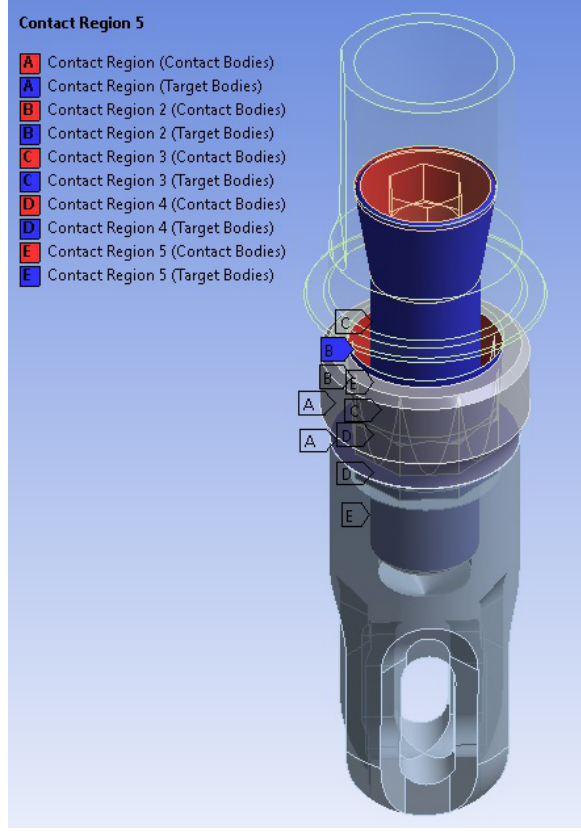
Figure 8. Contact regions of the new IH variant inside the ANSYS environment.